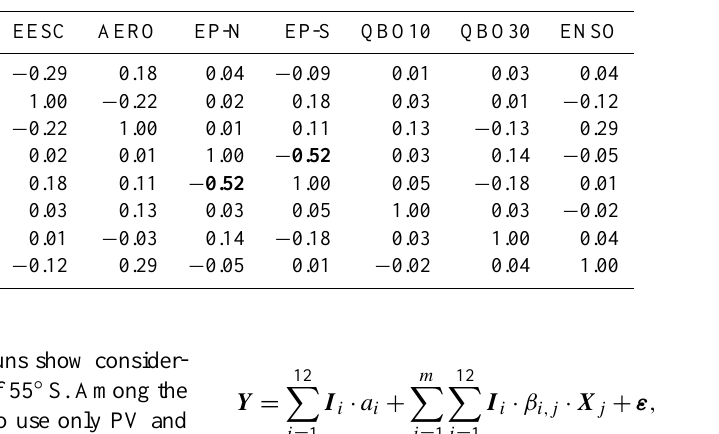
Table 2. Table of correlations for non-gridded proxies. Due to high correlation values between EP-N and EP-S, these variables are only used in the Northern and Southern Hemisphere, respectively. QBO10 and QBO30 represent the QBO index at 10 and at 30hPa, respectively. Correlations greater than 0.4 are emphasized